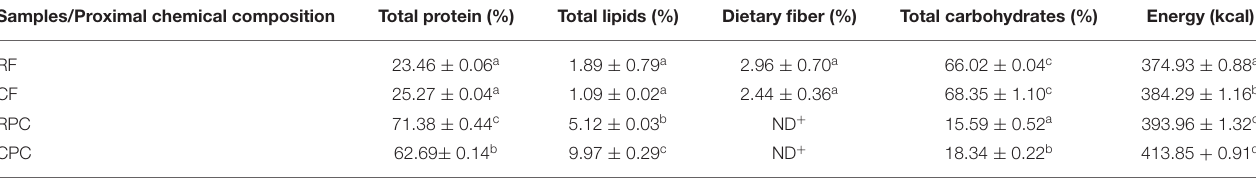
TABLE 4 | Proximal chemical composition of tepary bean flours (RF and CF) and protein concentrates (RPC and CPC) * . Samples/Proximal chemical composition